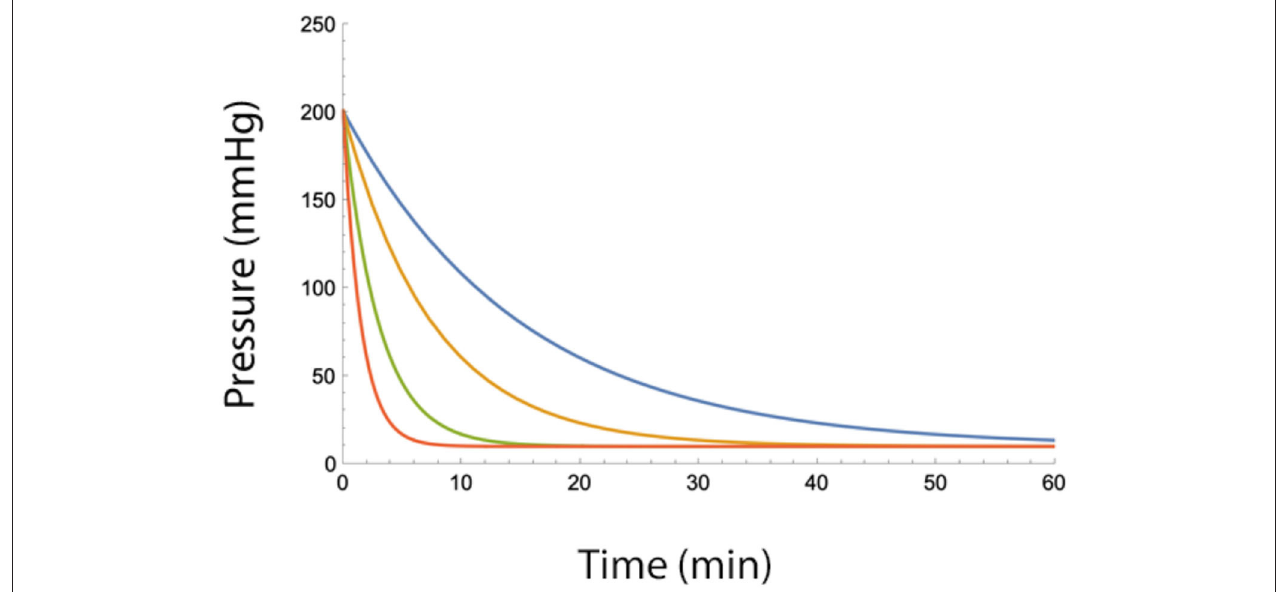
FIGURE 2 | Epidural pressure as a function of time after injection of a bolus of fluid in the epidural space for different fluid egress conditions (i.e., low values of B). Blue B 2, Yellow B 4, Green B 7, and Red B 10 (ml/min). Total injected volume is 20ml, A = = = =